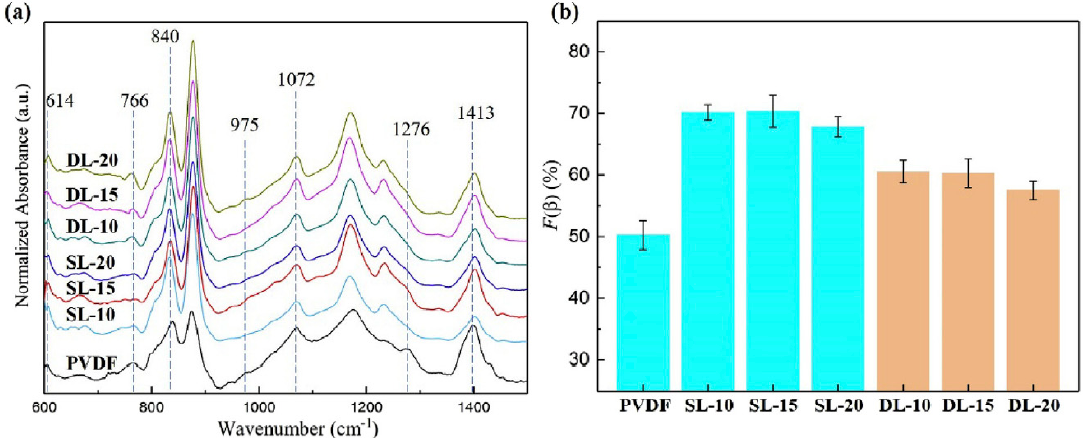
Figure 7. ( a ) FT-IR spectra and ( b ) concentration of β -phase at different concentrations of BaTiO 3 [46].